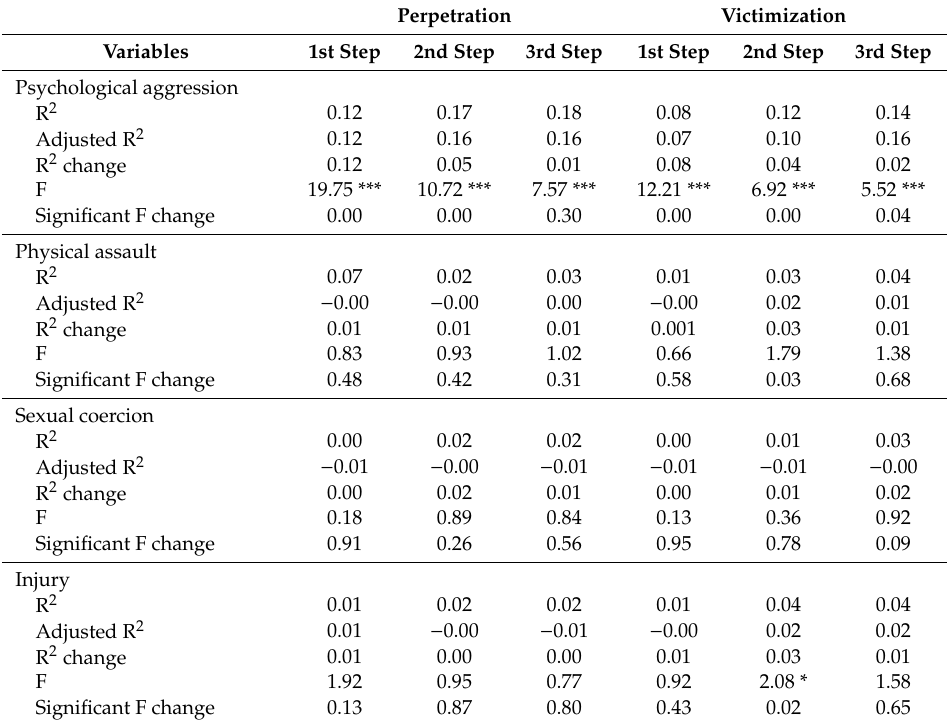
Table 3. Multiple regression analysis for experience of dating violence by socio − demographic variables, impulsivity and